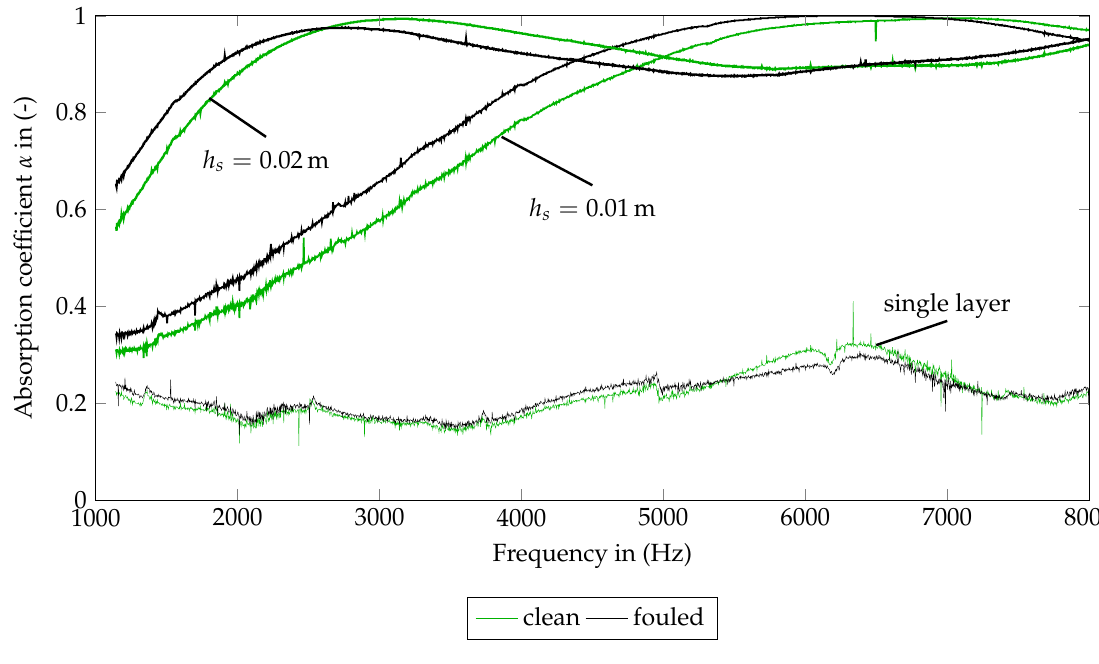
Figure 5. Measured frequency-dependent absorption coefficients of clean (0 M) and fouled (12 M) SFF 100 for one layer and staple sizes of 0.01m and 0.02m.